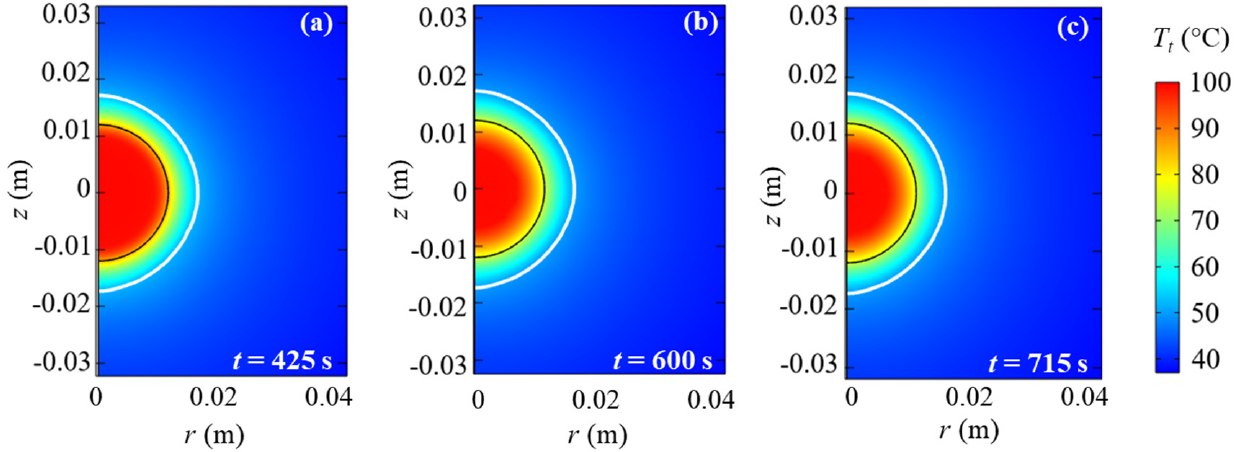
Figure 9. Temperature fields achieved at the end of ( a ) constant protocol, ( b ) damage-controlled protocol, and ( c ) pulsating protocol. The white line corresponds to Ω = 4.6 (99% cell death probability) contour, reached at target radius ( r = 1.7 cm) in all the cases. The black line is the tumor contour.